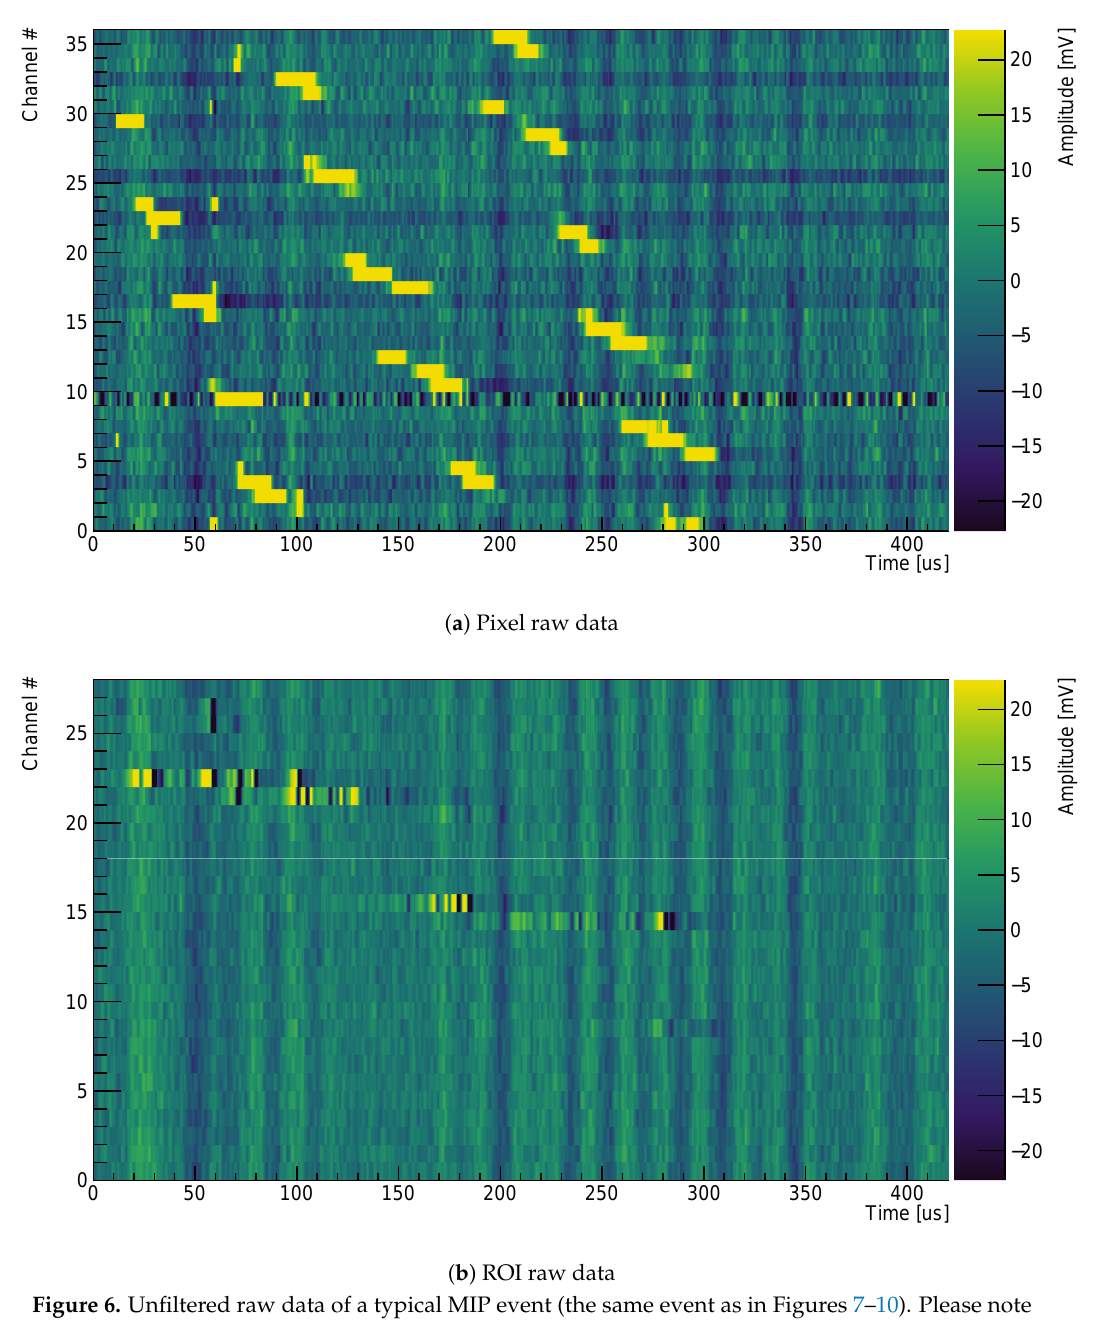
Figure 6. Unfiltered raw data of a typical MIP event (the same event as in Figures 7–10). Please note that the color scale was adjusted to highlight the charge signals. Therefore, most signal peaks are above/below the maximum/minimum of the color scale. The full range of a typical signal can be seen in Figure